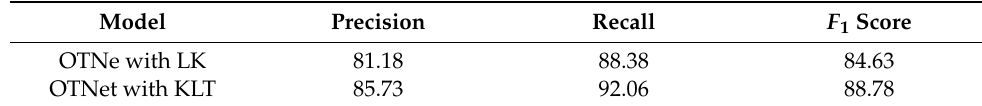
Figure 5. The structure of our algorithm. ( a ) The ground truth. ( b ) The KLT result. ( c ) The LK result. Table 3. The location performance results of the models.